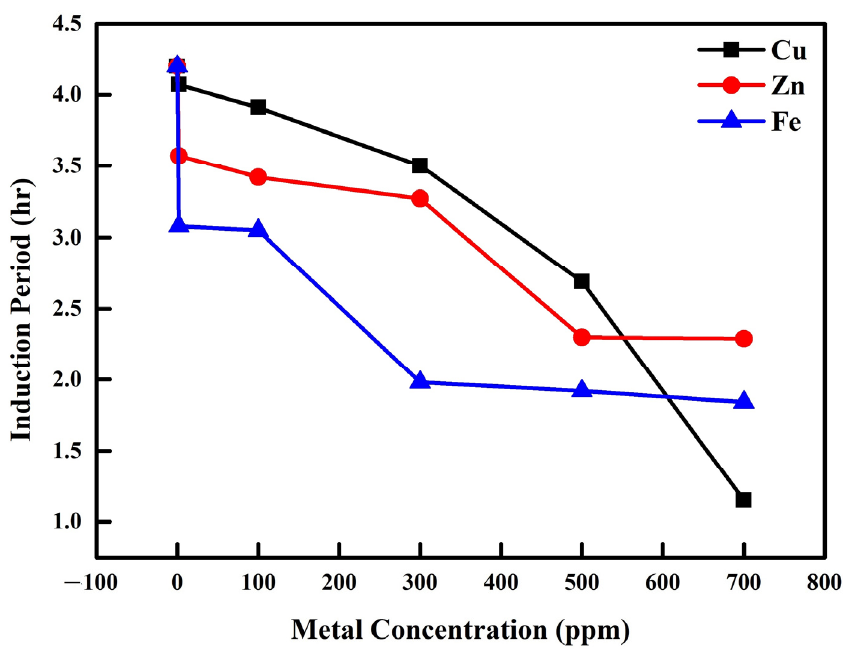
Figure 5. Oxidation stability in sunflower biodiesel before and after exposure to metals.